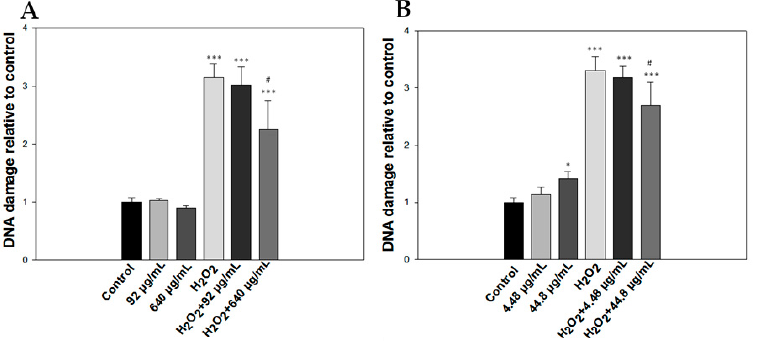
Jurkat cells (2 × 10 4 ) were preincubated with Lippia citriodora oil ( A ) or citral ( B ) for 20 min before treatment with H 2 O 2 (6.66 µ g/mL) for 20 min at room temperature. Results are shown as mean ± S.D. # p = 0.013 H µ g/mL essential oil, # p < 0.05 relative to H 2 O 2 vs. H 2 O 2 and 640 2 O 2 , *** p < 0.001 relative to